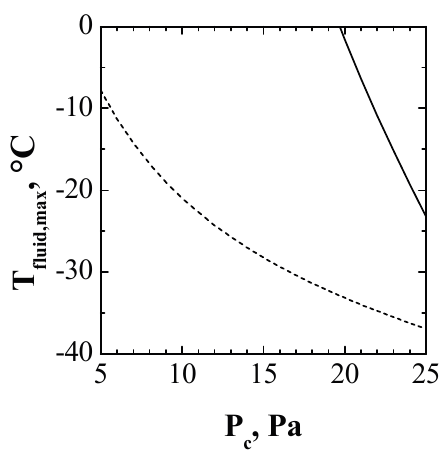
Figure 8. Design space of the primary drying stage calculated in case product temperature remains below the glass transition value (dashed line) and below the collapse value (solid line) for the 5% w/w sucrose solution investigated in this study.